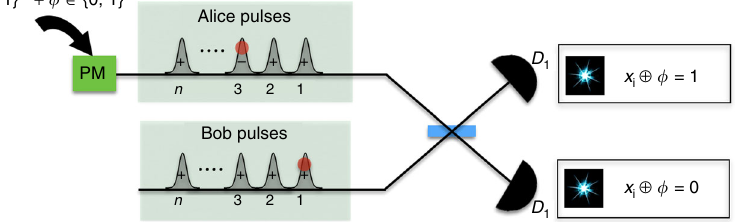
Fig. 3 Circuit illustration for the implementation of Sampling Matching using coherent states for any input size n . Alice prepares her message by encoding her input x ∈ {0, 1} n and an additional factor ϕ ∈ {0, 1} on the phase of a train of coherent states, using a phase modulator (PM), to produce the coherent state fi ngerprint | α x 〉 . Bob, on his side, produces a sequence of n states with the same total mean number as Alice ’ s state, interferes his pulses with Alice ’ s sequentially on a balanced beam splitter, and obtains the parity information from the clicks on the single-photon detectors D 0 and D 1 . As an example, the red dots in the fi rst and third time slots of Alice ’ s and Bob ’ s sequences, respectively, indicate that Bob observes a single click at D 1 and D 0 detectors respectively for these time slots, and thus he outputs x 1 ⊕ x 3 = 1. If he obtains single clicks at more than two time slots, then he randomly chooses any two of them to output the parity outcome